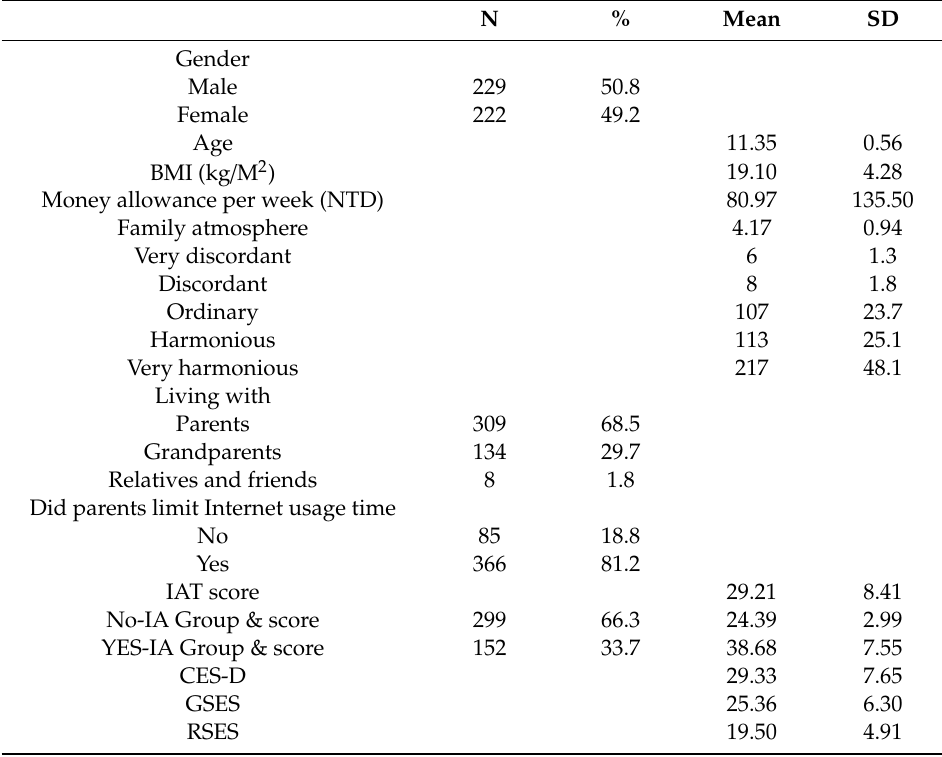
Table1. Descriptivestatisticsofdemographics, familyfunctionality, depression, self-e ffi cacy, self-esteem and IAT ( n =